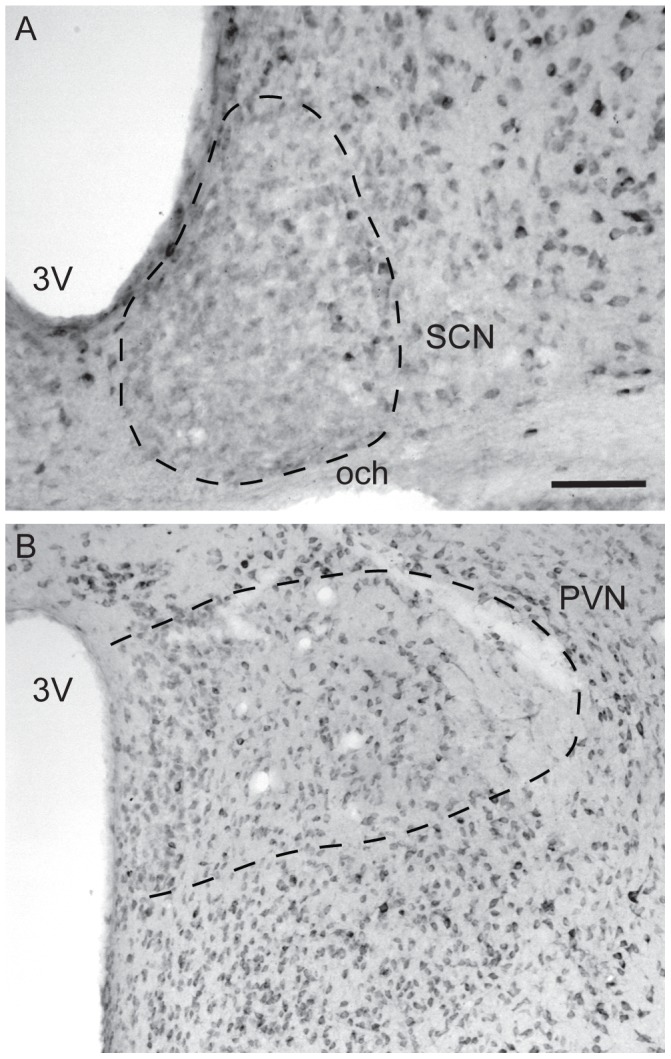
Example of RUNX2 immunolabeling in the suprachiasmatic nucleus (SCN) and paraventricular nucleus (PVN) in a representative adult male mouse at CT9.The dotted lines outline the area of interest, the SCN in A and the PVN in B. Scale bar depicts 125 µm in A and 250 µm in B. Abbreviations: 3V: third ventricle; och: optic chiasm; PVN: paraventricular nucleus; SCN: suprachiasmatic nucleus.